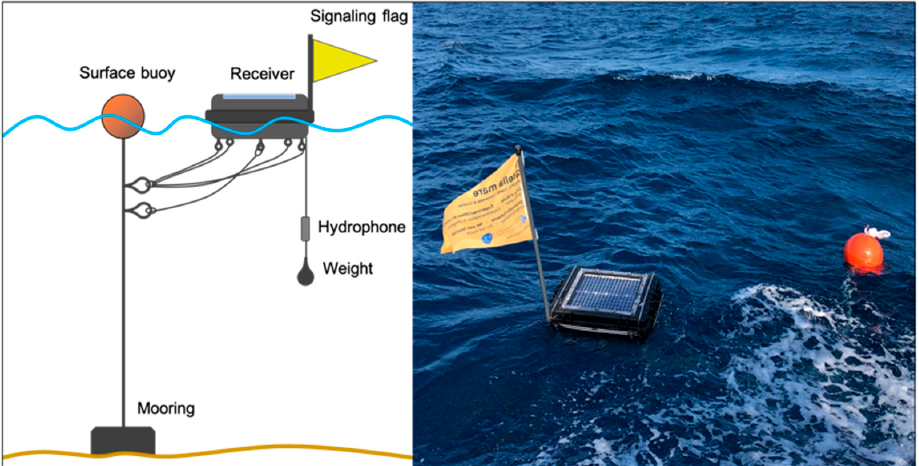
Figure 6. On the left, an illustrative diagram of the deployment of an acoustic receiver at sea. It shows how the different elements (mooring, buoys, receiver, signal flags, hydrophone, weights and ropes) are placed in relation to each other. On the right, a picture of a deployed receiver.